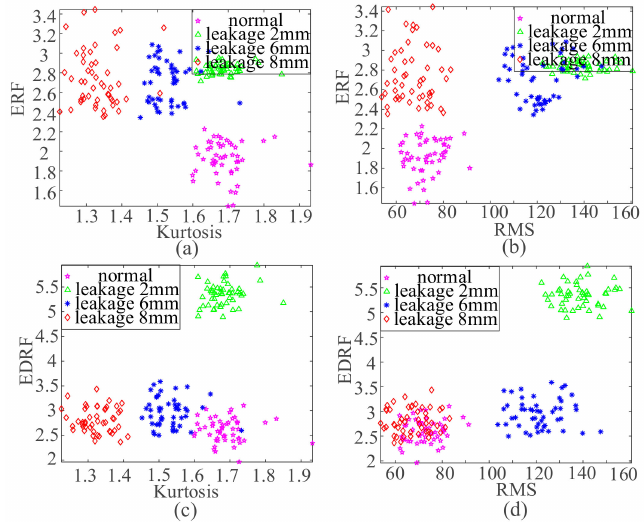
Figure 14. SVM classification e ff ect of system Cis; ( a – d ) are the classification e ff ect of K and ERF, RMS and ERF, K and EDRF as well as RMS and EDRF as characteristic indicators,